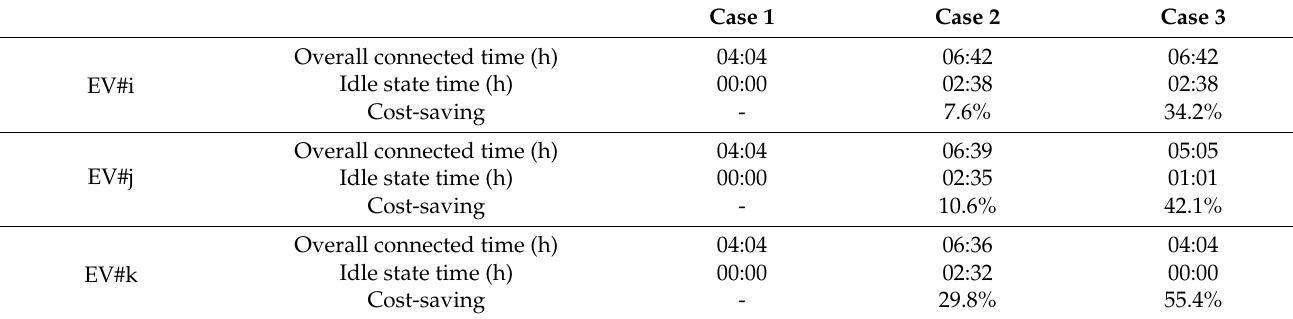
Table 3. Obtained results for the arbitrary